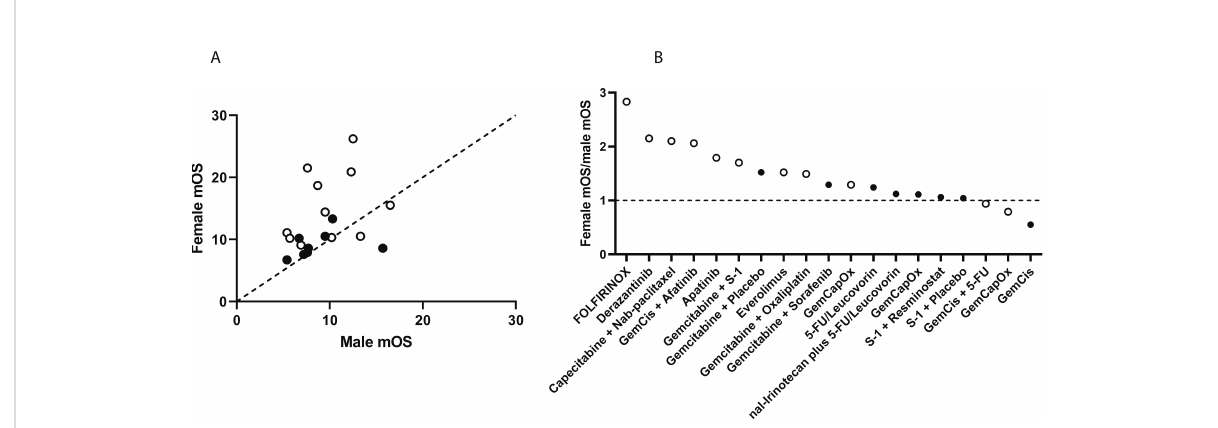
FIGURE 2 Comparison of median overall survival (OS) in female and male participants in treatment trials of cholangiocarcinoma. (A) Data were obtained from participants in 19 treatment groups from 15 studies. Treatment groups above the dotted line of equivalence have a higher overall survival in females compared with males. (B) The ratio of median OS in females to median OS in males is plotted for each treatment group. Treatments with higher median OS in females are plotted above the dotted line, with ratio >1. Randomized of treatment was performed in studies represented by solid dots, non-randomized studies as open dots.